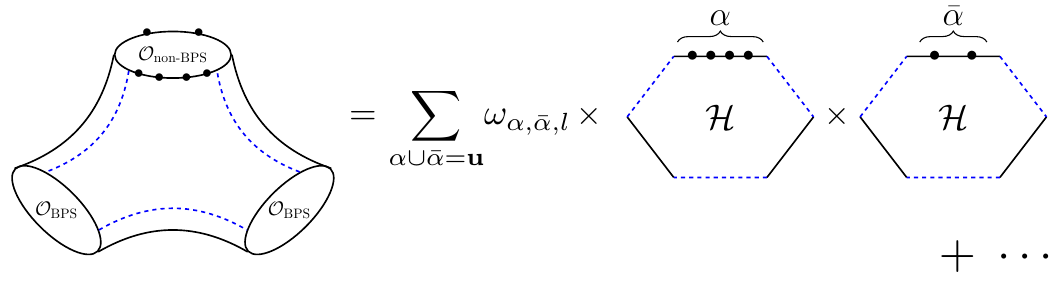
Figure 15 . The asymptotic part of the BKV formula for structure constants of two protected and one non-protected operators, consists on a sum over bi-partitions of the set of Bethe roots describing the non-BPS operator: (cid:11) (cid:22) (cid:11) = u . The summand is given by a product of two hexagon [ form factors, each evaluated in one of the bi-partitions: and , and a weight factor depending H (cid:11) H (cid:22) (cid:11) on the partitions and the length l of the bridge connecting the non-protected operator and one of protected